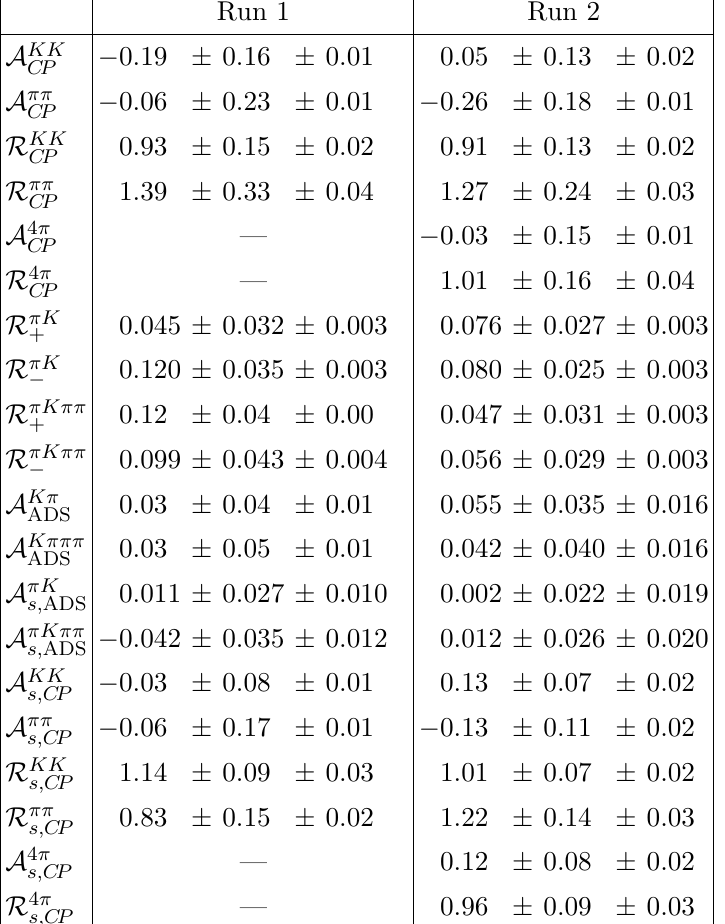
Table 3 . Measured observables split by LHC running period. Observables relating to B 0 ! D ( (cid:25) + (cid:25) (cid:0) (cid:25) + (cid:25) (cid:0) ) K (cid:3) 0 decays are not presented for Run 1, as this decay channel was not selected in the Run 1